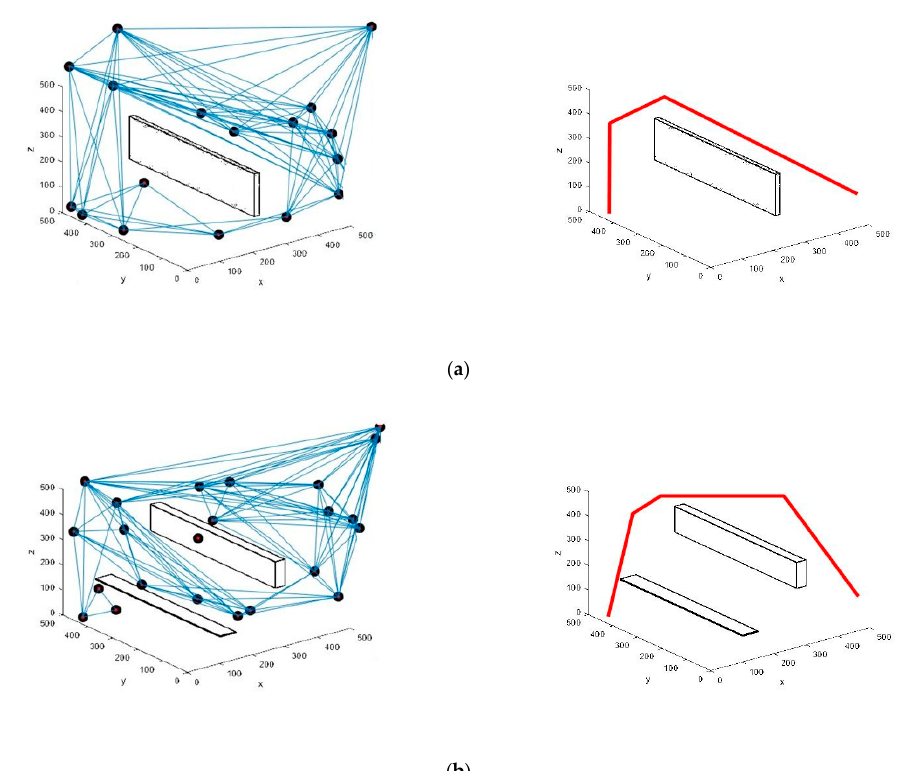
Figure 4. UAV’s path using PRM algorithm in two different scenarios: ( a ) single static obstacle and ( b ) multiple obstacles.